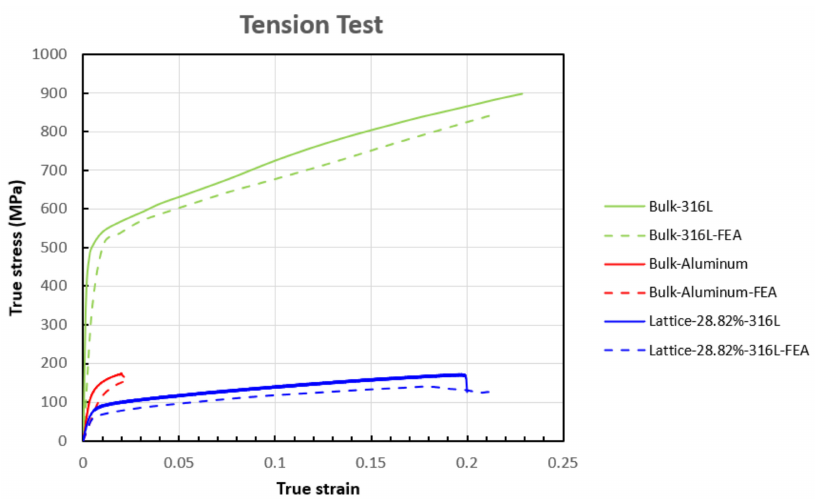
Figure 8. Comparison between experimental and FEA results of bulk 316L stainless steel, bulk dissolvable aluminum, and 316L stainless steel lattice for the tension